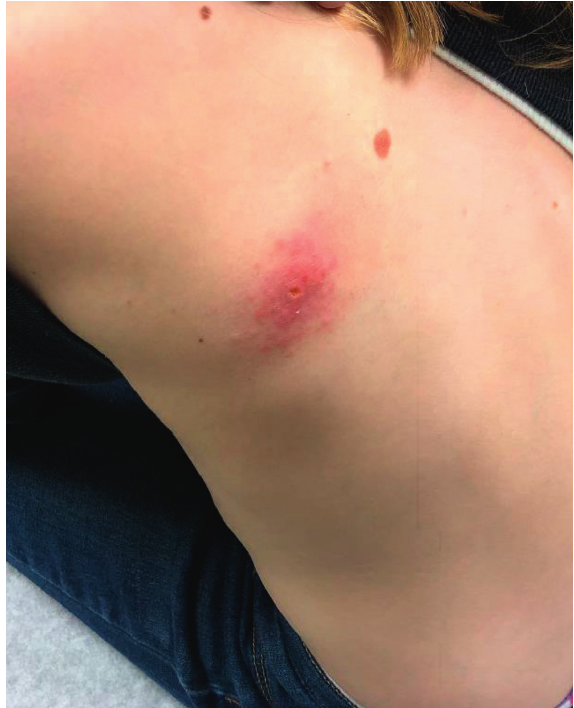
Figure 1: An edematous and erythematous plaque with purulent drainage on the left upper